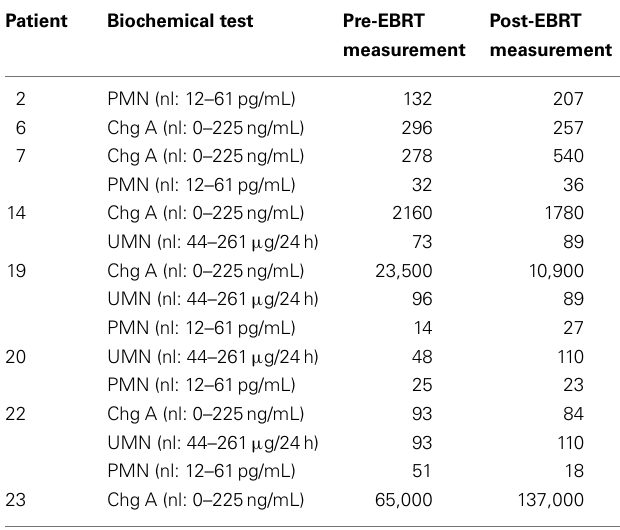
Table 4 | Biochemical responses to EBRT